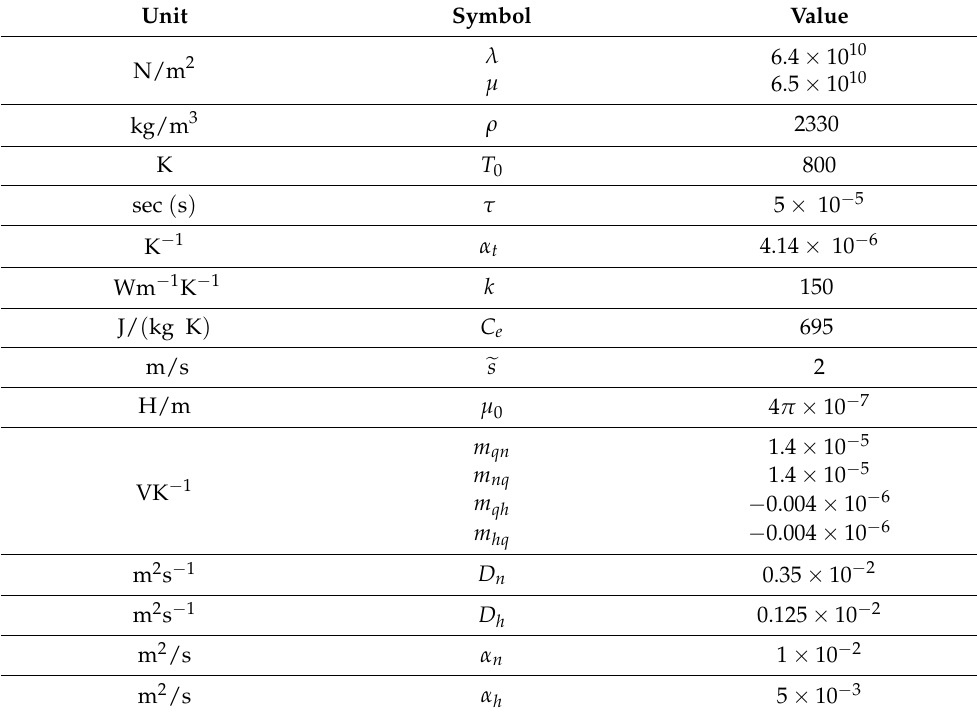
Table 1. The physical parameters of Si material in SI